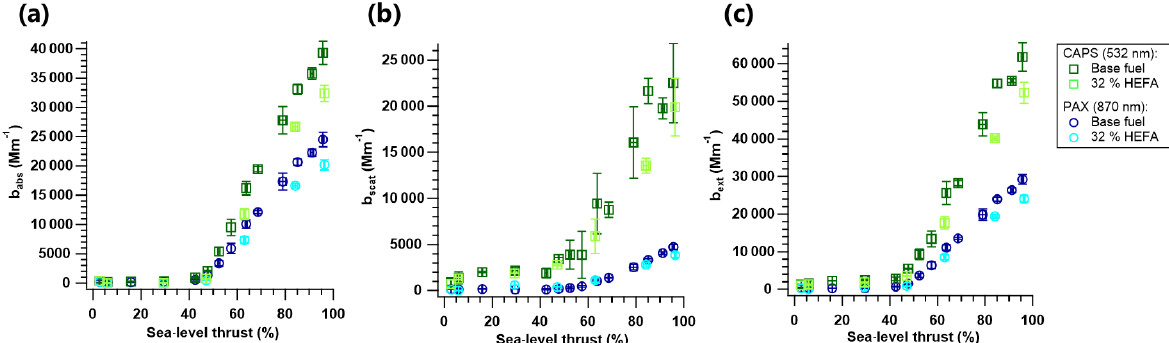
Figure 4. Thrust-dependent (a) absorption coefficient ( b abs ), (b) scattering coefficient ( b scat ) and (c) extinction coefficient ( b ext ) measured at 532nm (green squares) and 870nm (blue circles). Note that dark colours represent measurements with base fuel (Jet A-1), and light colours represent measurements with the 32%vol HEFA blend.